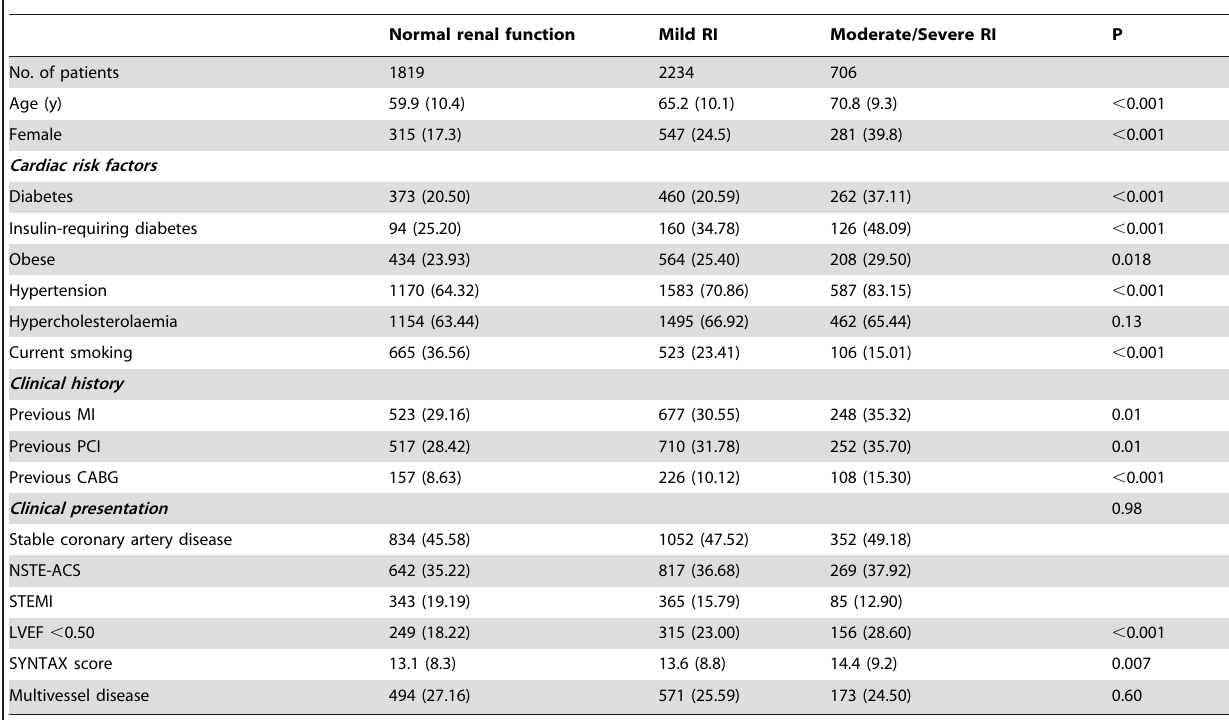
Table 1. Clinical Characteristics at